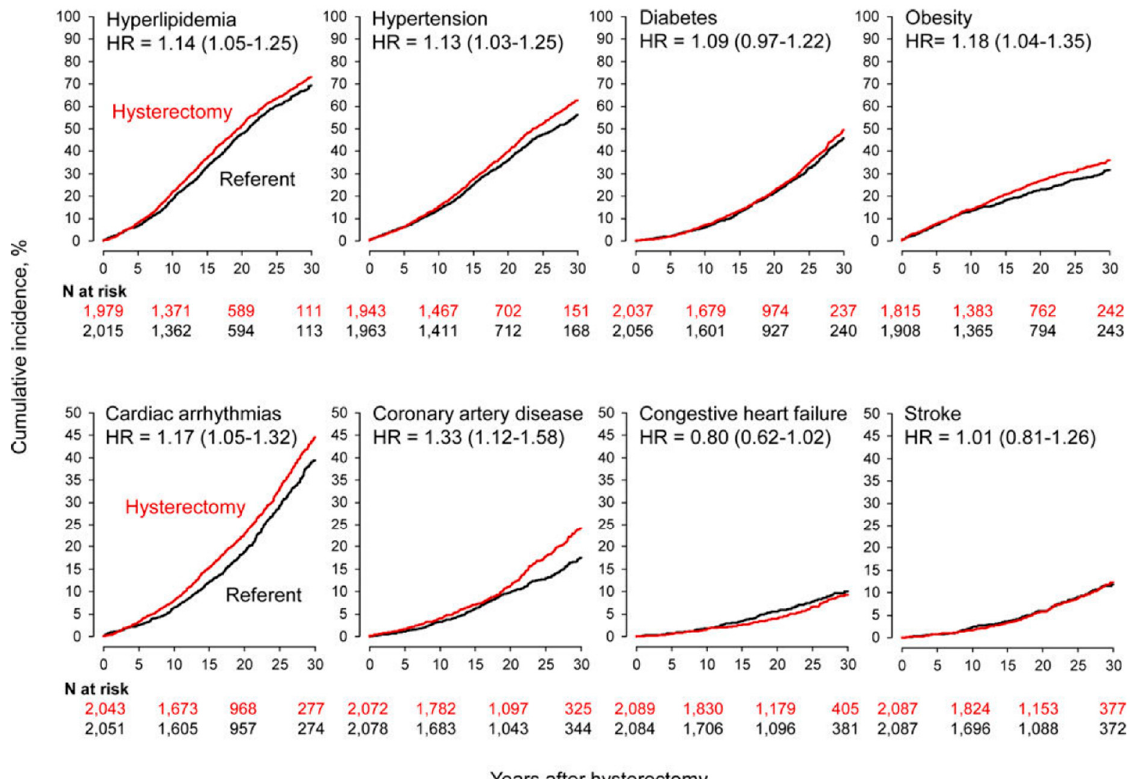
Figure 1. Cumulative incidence curves for cardiovascular and metabolic conditions in women who underwent hysterectomy with ovarian conservation at 35 years or younger compared with age-matched referent women (stratified analyses). The hazard ratios (HRs) and corresponding 95% confidence intervals were calculated using Cox proportional hazards models with age as the time scale and adjusted using inverse probability weights. Reprinted from Menopause , Cardiovascular and metabolic morbidity after hysterectomy with ovarian conservation: a cohort study, 25: 483–492, ©2018, with permission from Wolters Kluwer Health, Inc. [34].